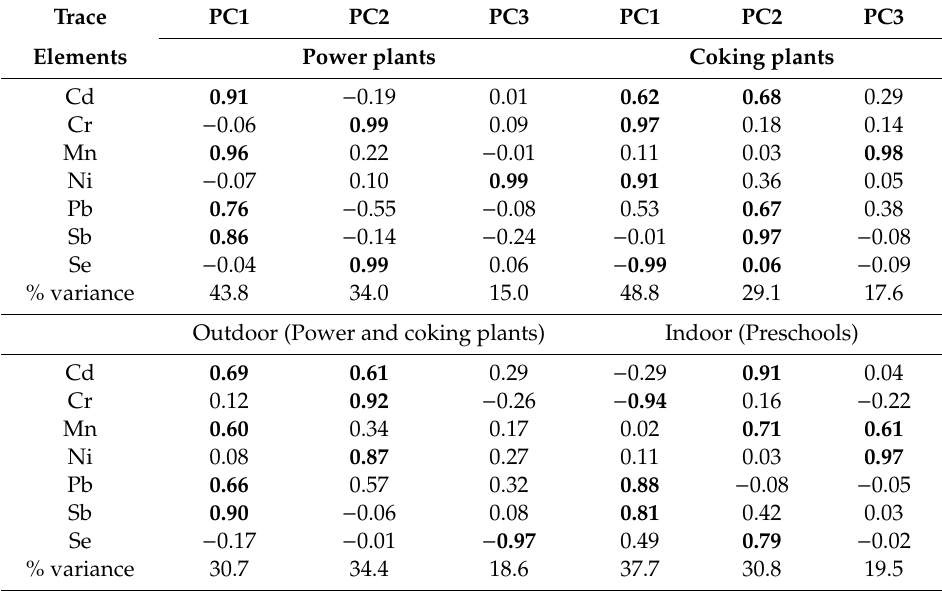
Table 2. Principal component analysis in PM